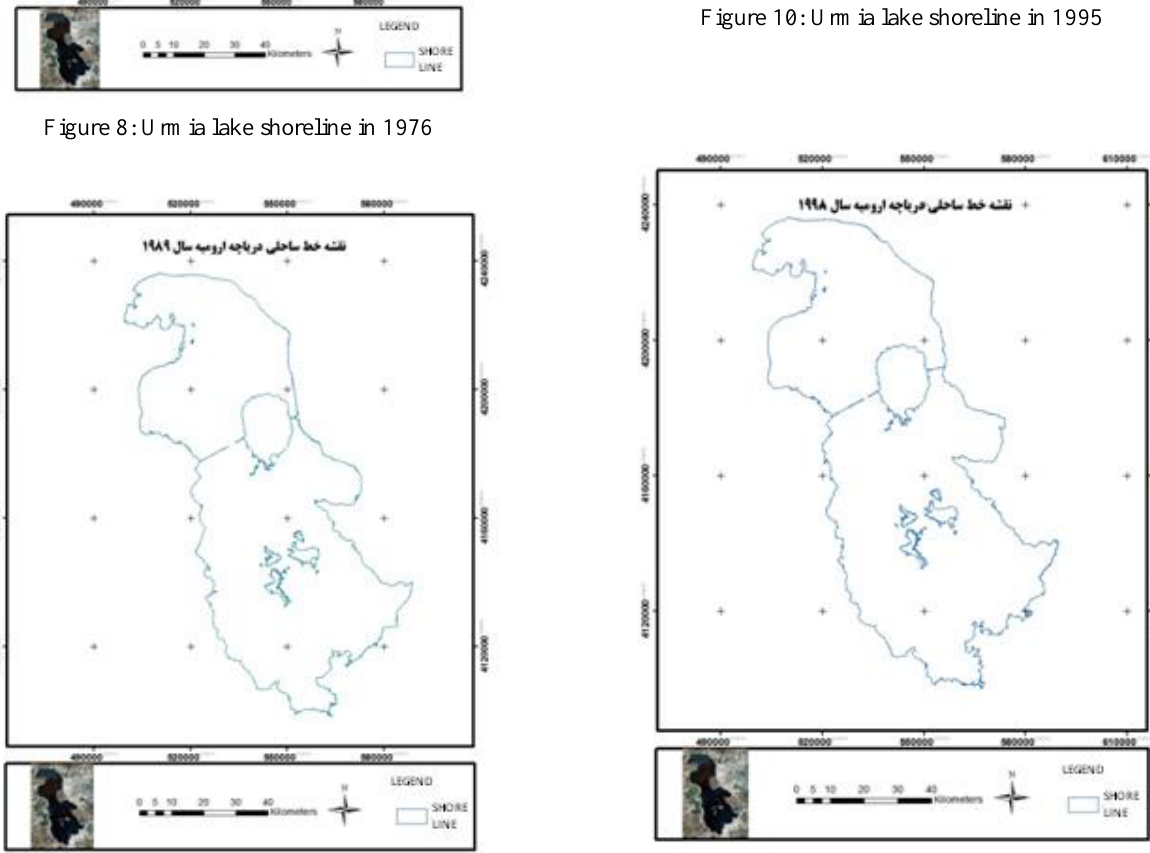
Figure 10: Urmia lake shoreline in 1995